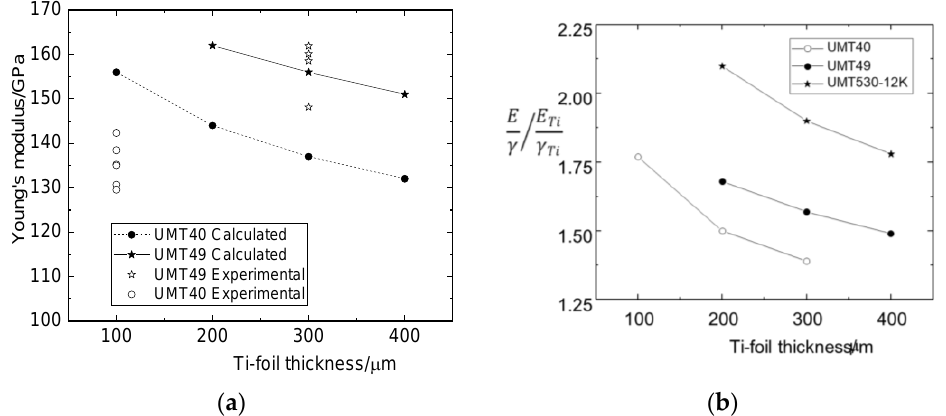
Figure 21. ( a ) Calculated values of the Young’s modulus of the composites (tension) and experimental data obtained in bending tests of the composite specimens. ( b ) Specific Young’s modulus of the composites tested in the present work and the prospective composites with high-modulus carbon fibres ( E = 530 GPa), normalized by that value for titanium.